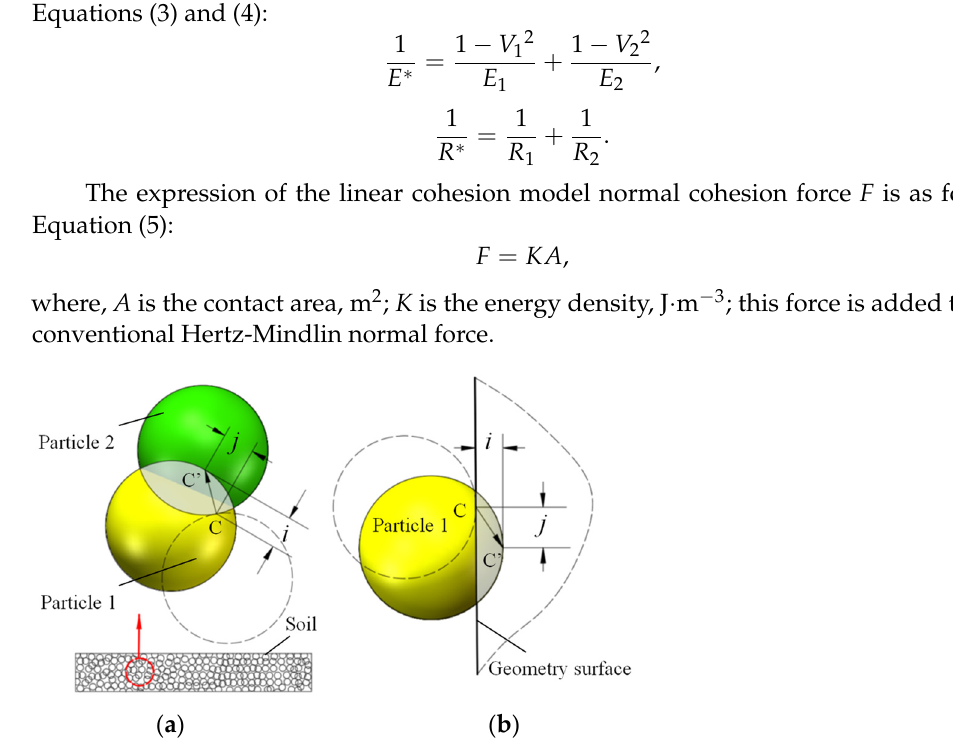
Figure 3. Contact model: ( a ) particle to particle; ( b ) particle to geometry.